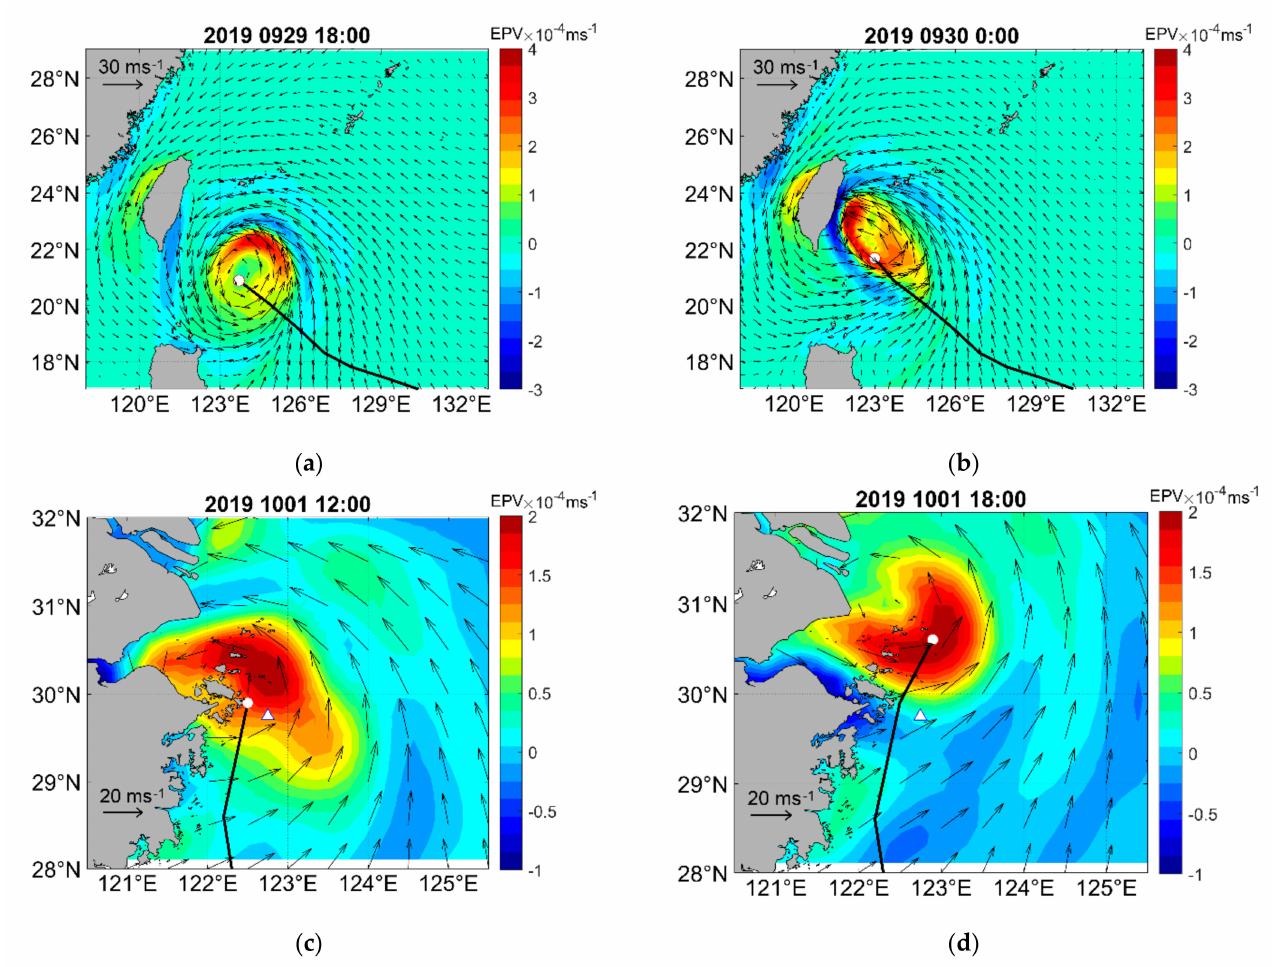
Figure 7. The Ekman pumping velocity distribution at different time. ( a ) 18:00 on 29 September. ( b ) 0:00 on 30 September. ( c ) 12:00 on 01 October. ( d ) 18:00 on 01 October. (The vectors represent wind, the black line is “MITAG” track, the white circle is center of “MITAG”, and the triangle is the location of Zhoushan